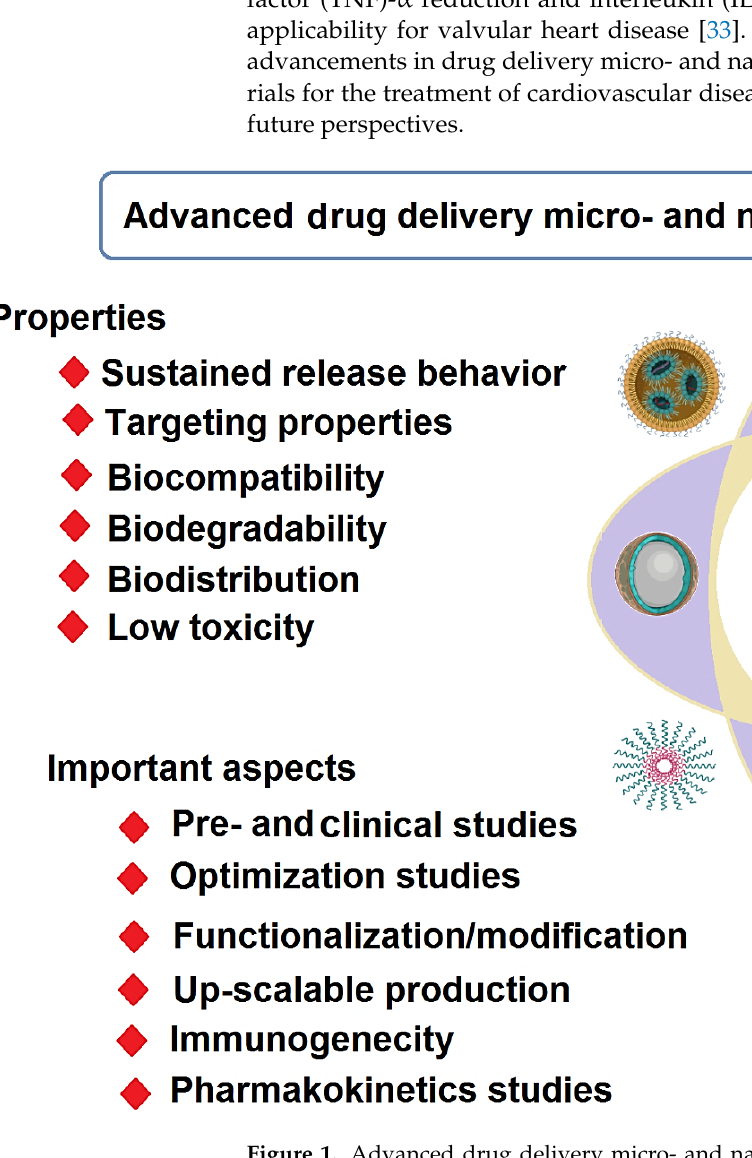
Figure 1. Advanced drug delivery micro- and nanosystems for CVDs: properties and challenging issues.